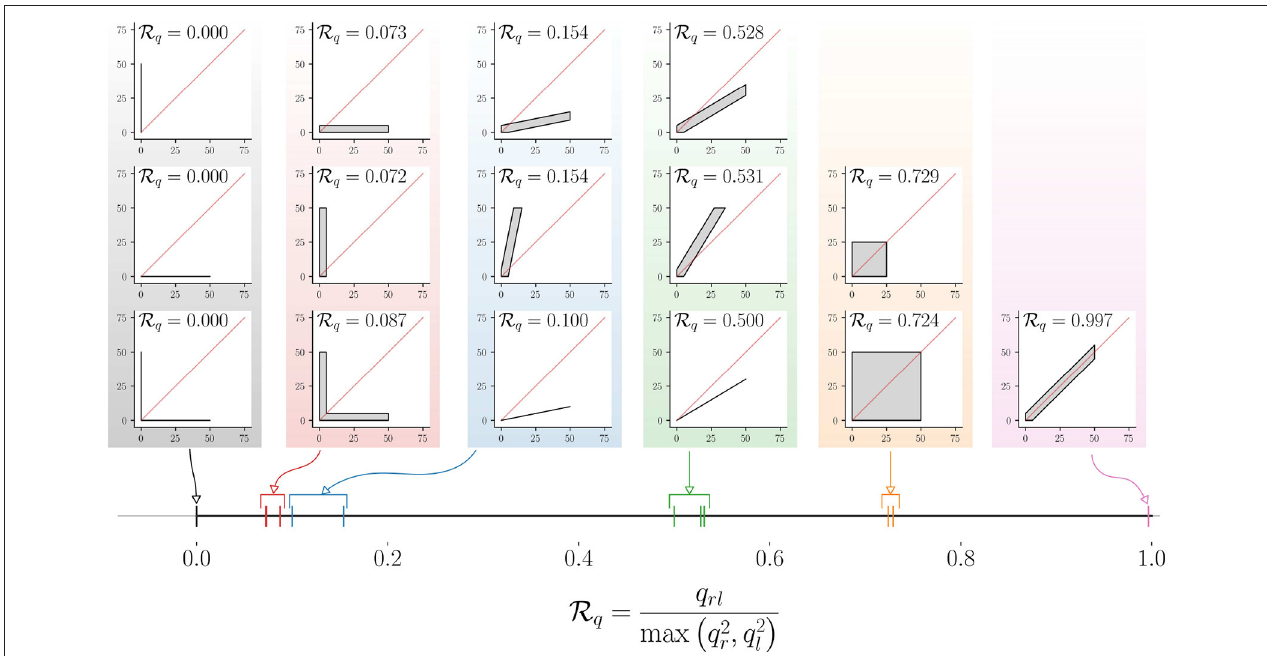
FIGURE 8 | Demonstration of the mapping of different types of relative upper-limb use to R q (here, q = 90). The different types of relative upper-limb use are depicted as LIRI plots grouped together to into different levels of relative upper-limb use. The leftmost column of three LIRI plots correspond to pure unimanual use. The different groups of LIRI plots from left to right correspond to reduced bias in using one limb over the other. The corresponding R q value for these different scenarios are displayed in the individual LIRI plots, and their mapping to the continuous interval [ 0,1 ] is shown in the